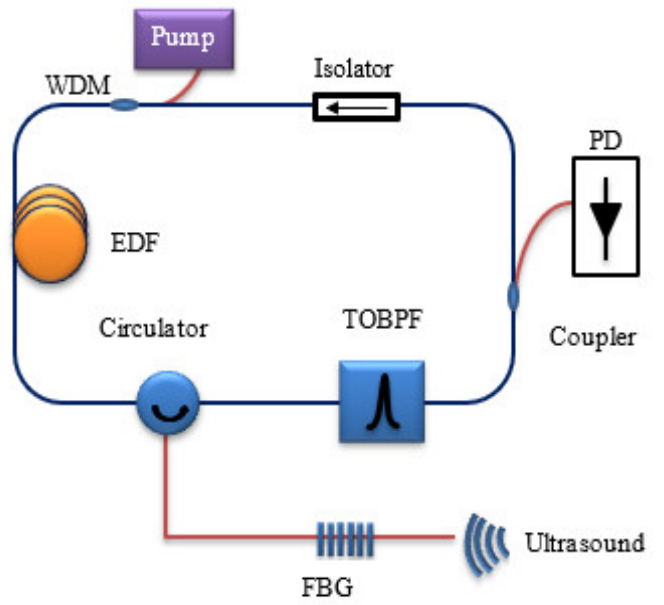
Figure 7. FBG Interrogation using a fibre ring laser (FRL)sensor for AE Detection [58].